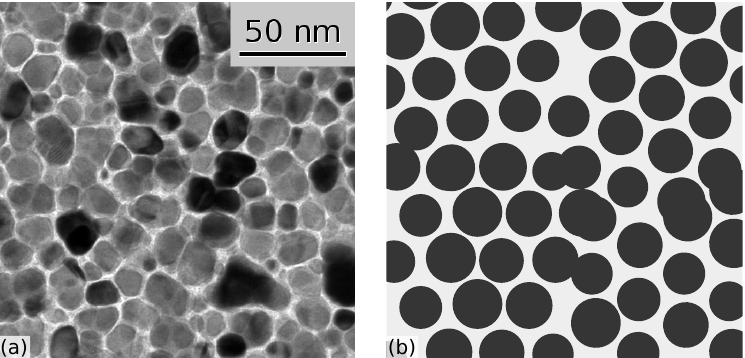
Figure 4. TEM image and model representation of the disordered film. (a) Top-view TEM image, (b) geometric model with four subsections of different random orientation (in each quarter of the image) and normally distributed diameters.